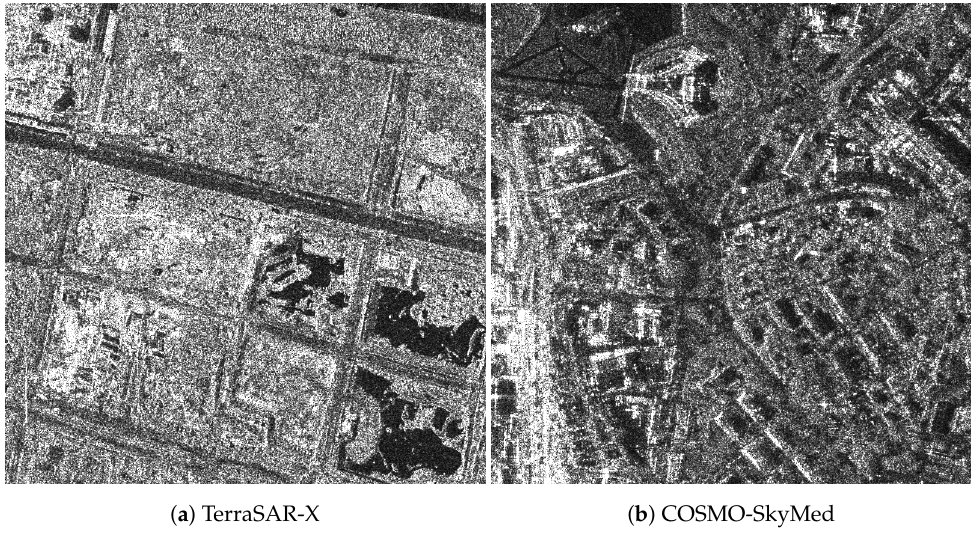
Figure 1. Examples of the real-world SAR image where noise-like speckle